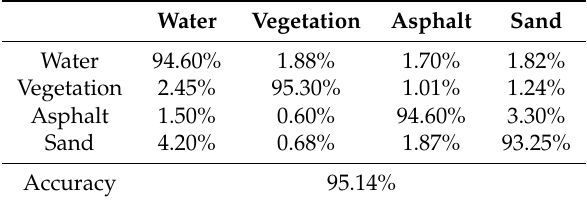
Table 2. Results based on GLCM, GLRLM and Optical flow